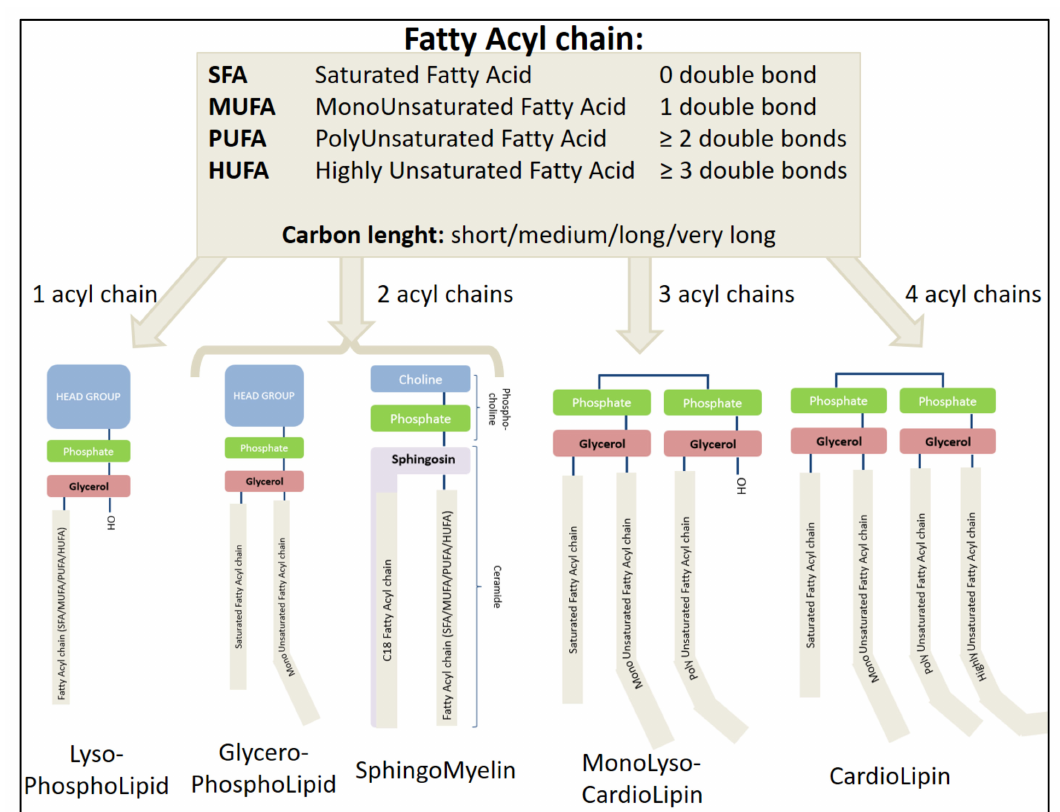
Figure 1. The great diversity of